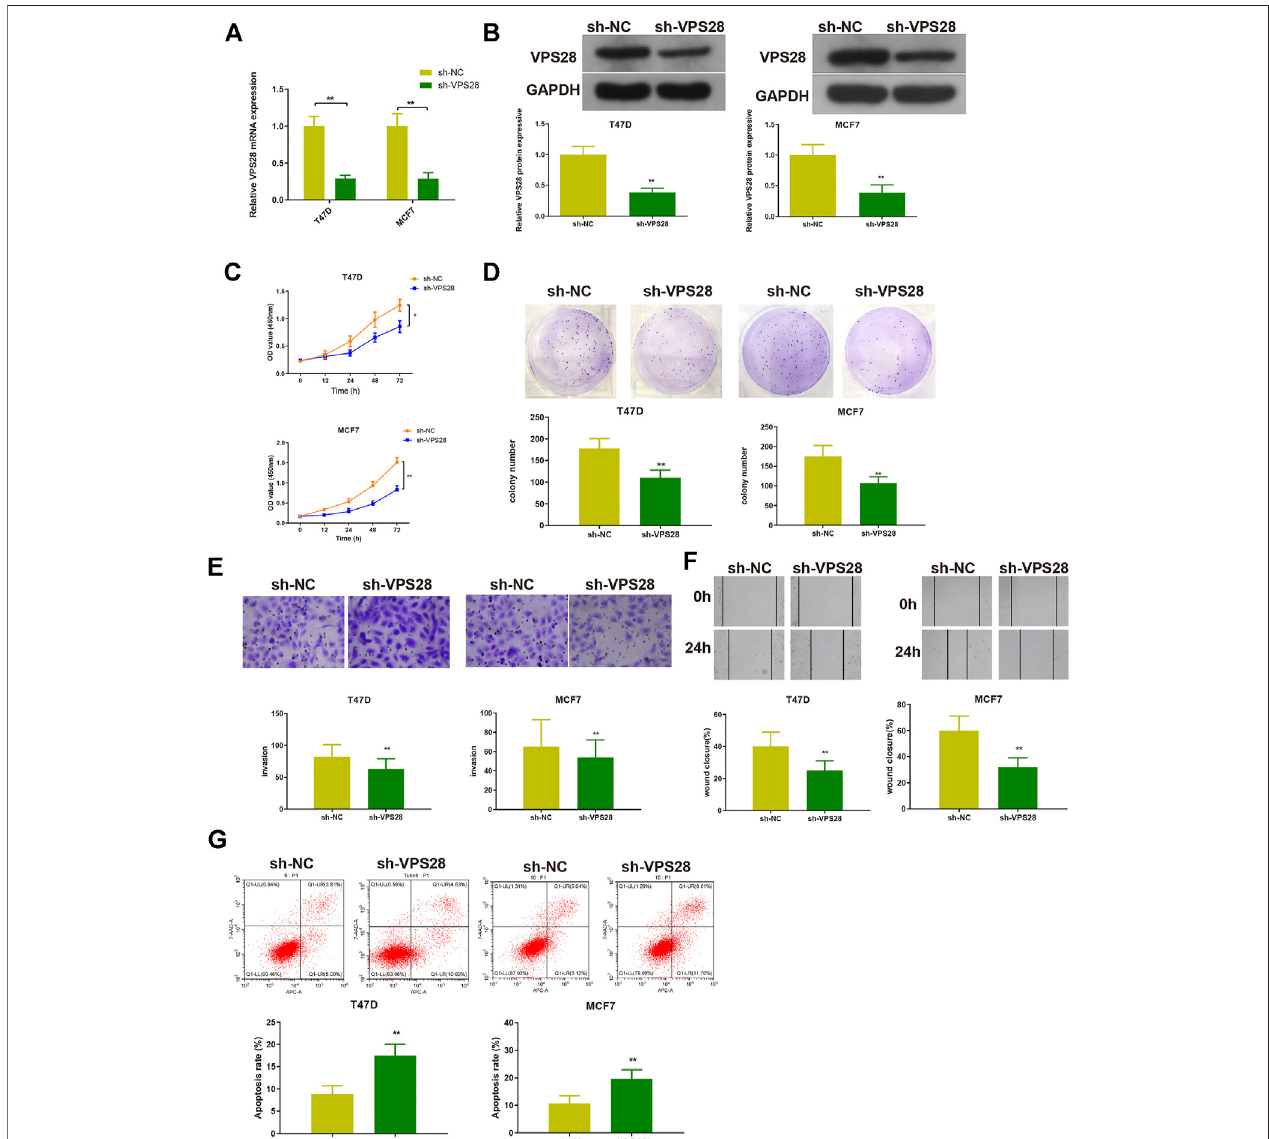
FIGURE 4 | The effect of VPS28 on the proliferation, migration, invasion ability, and apoptosis of breast cancer cells was determined after cells were transfected with sh-NC or sh-VPS28. The transfection ef fi ciency was veri fi ed by qRT-PCR (A) and Western blotting (B) . After cell transfection, the cell viability (C) , and clone formation (D) , migration (E) , and invasion (F) abilities were measured. Cell apoptosis was determined by fl ow cytometry (G) . * p < 0.05, ** p < 0.01, n (cid:1) 3.